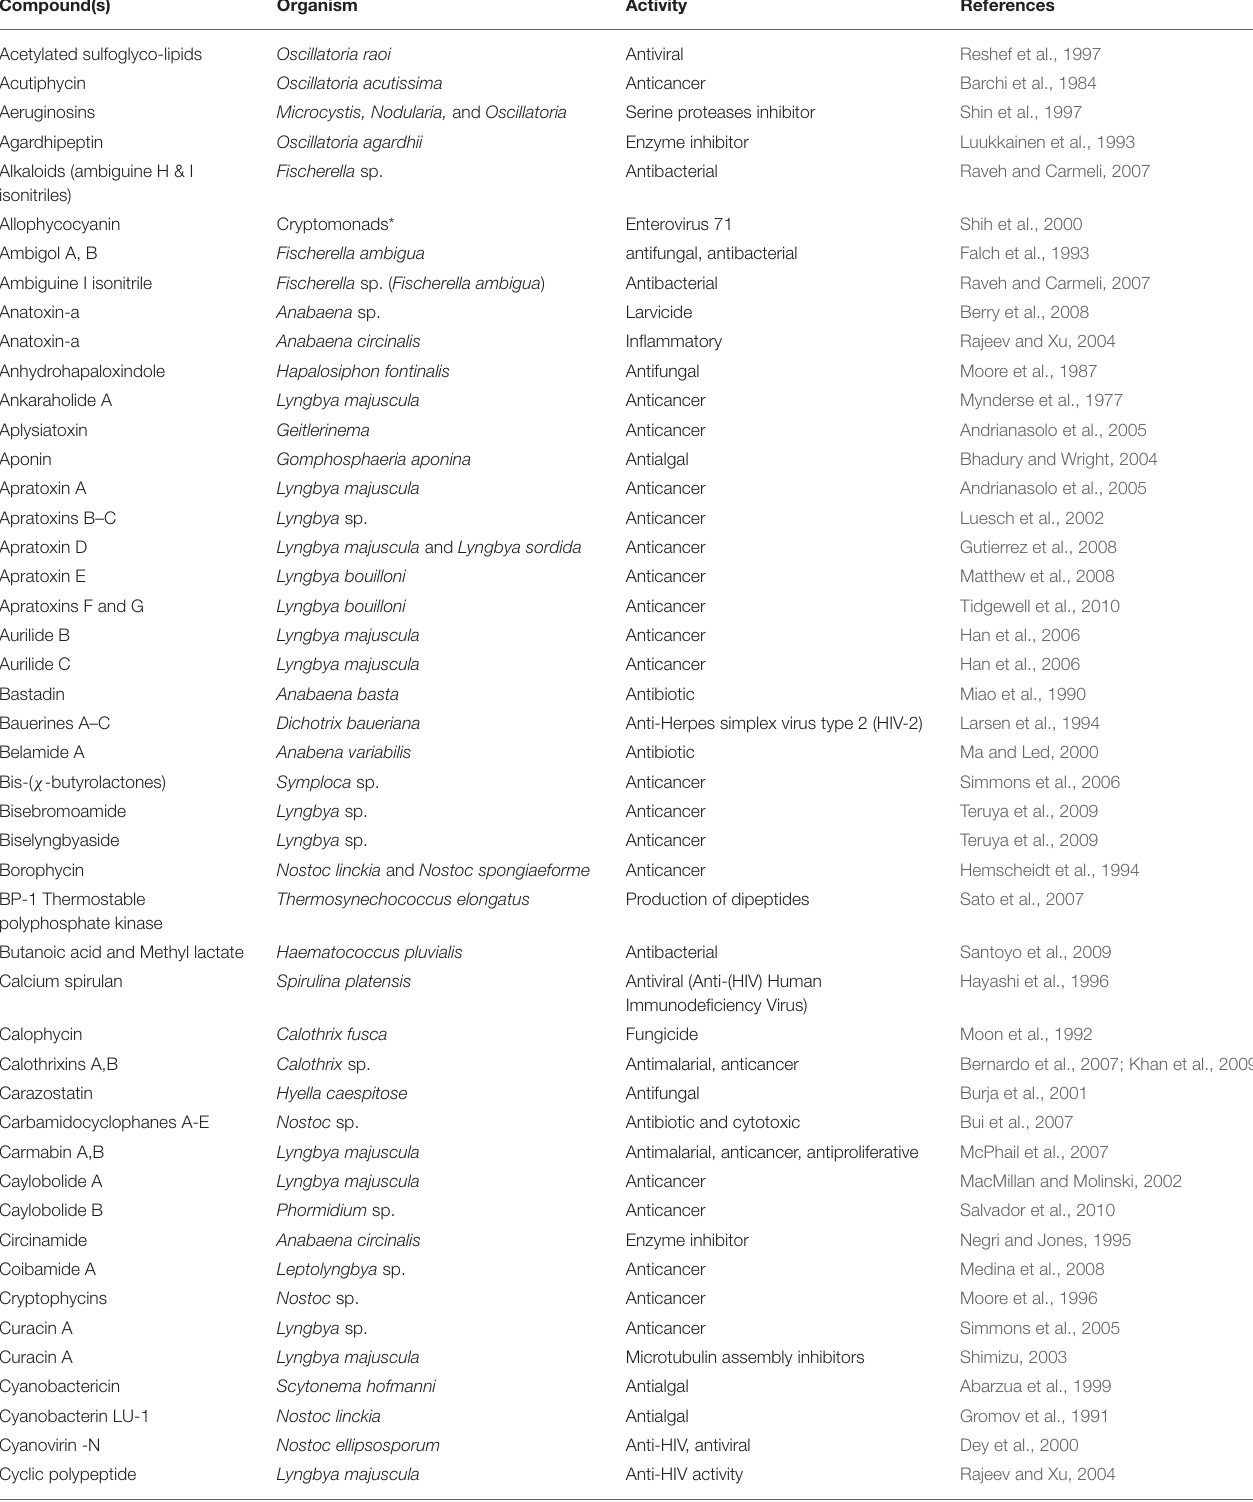
TABLE 4 | Various therapeutic agents produced by cyanobacteria and algae and their potential